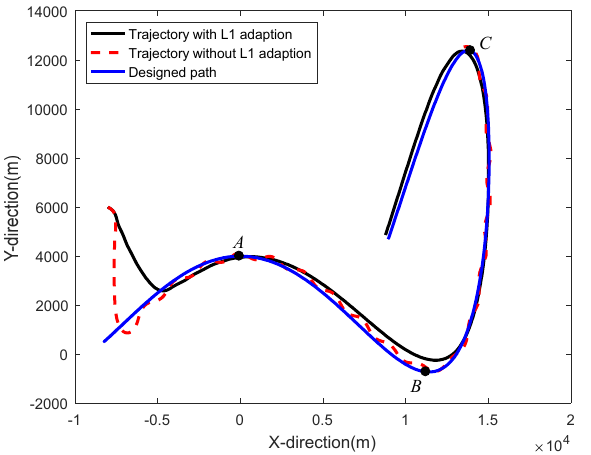
Figure 4. Path-following performances with and without the 𝐿 (cid:2869) adaptive control.